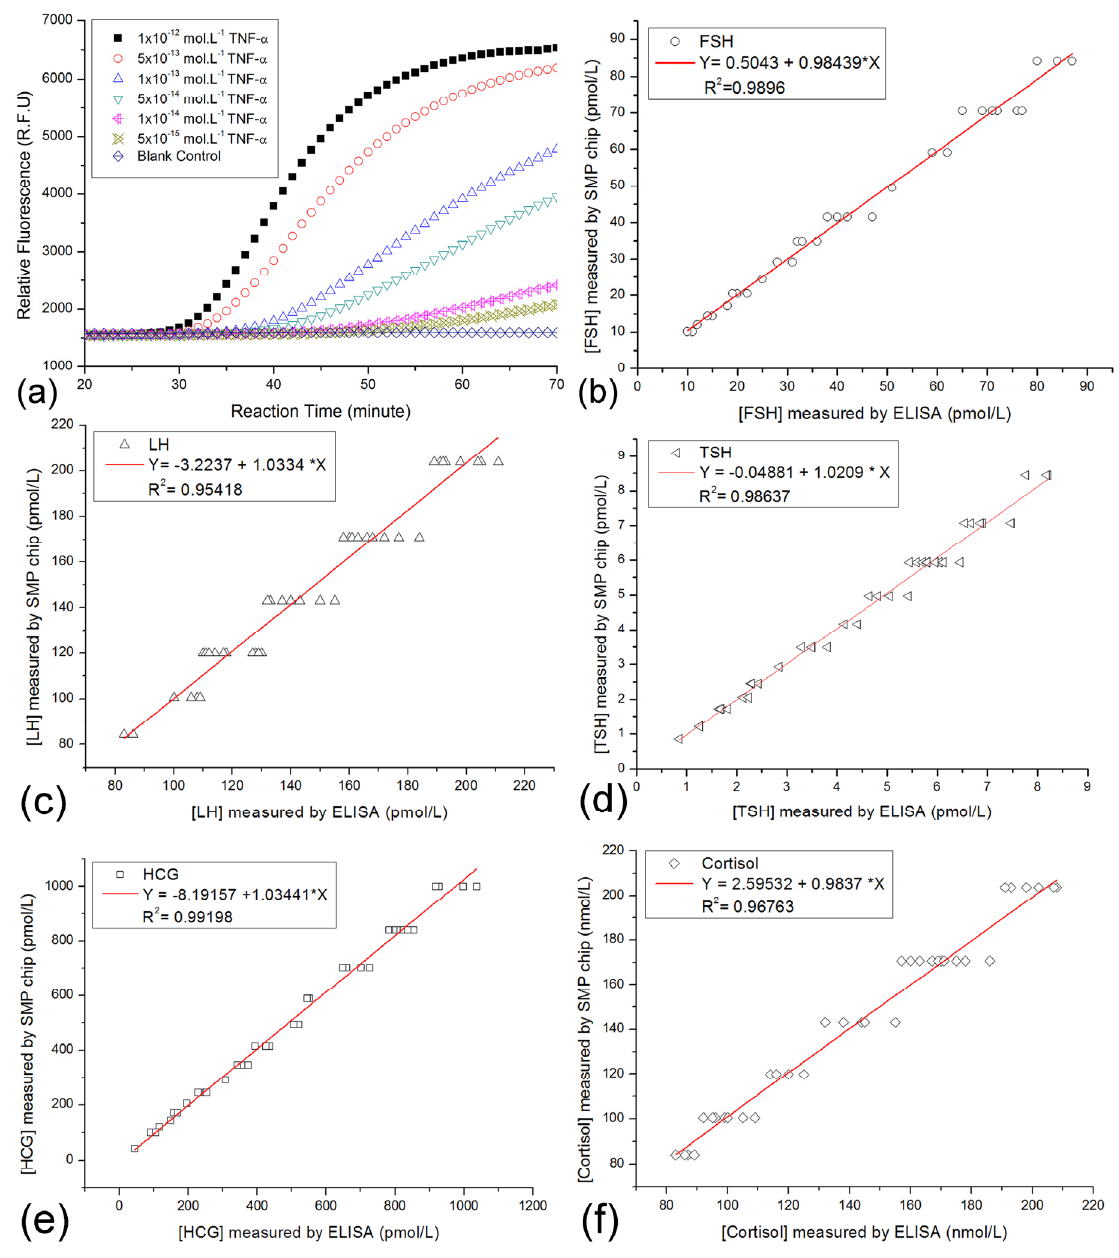
ELISA method. ( a ) Plot A showed the typical curves of on-chip immuno-NASBA assays using artificial TNF- α solutions as the standard